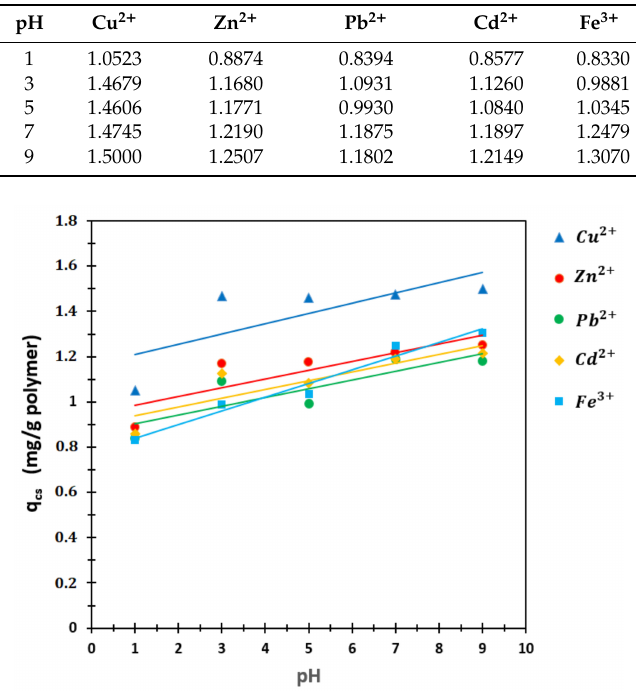
Table 5. Competitive sorption (q cs ) values against di ff erent pHs on the P (AA-co-Kry23-DM) SAP.